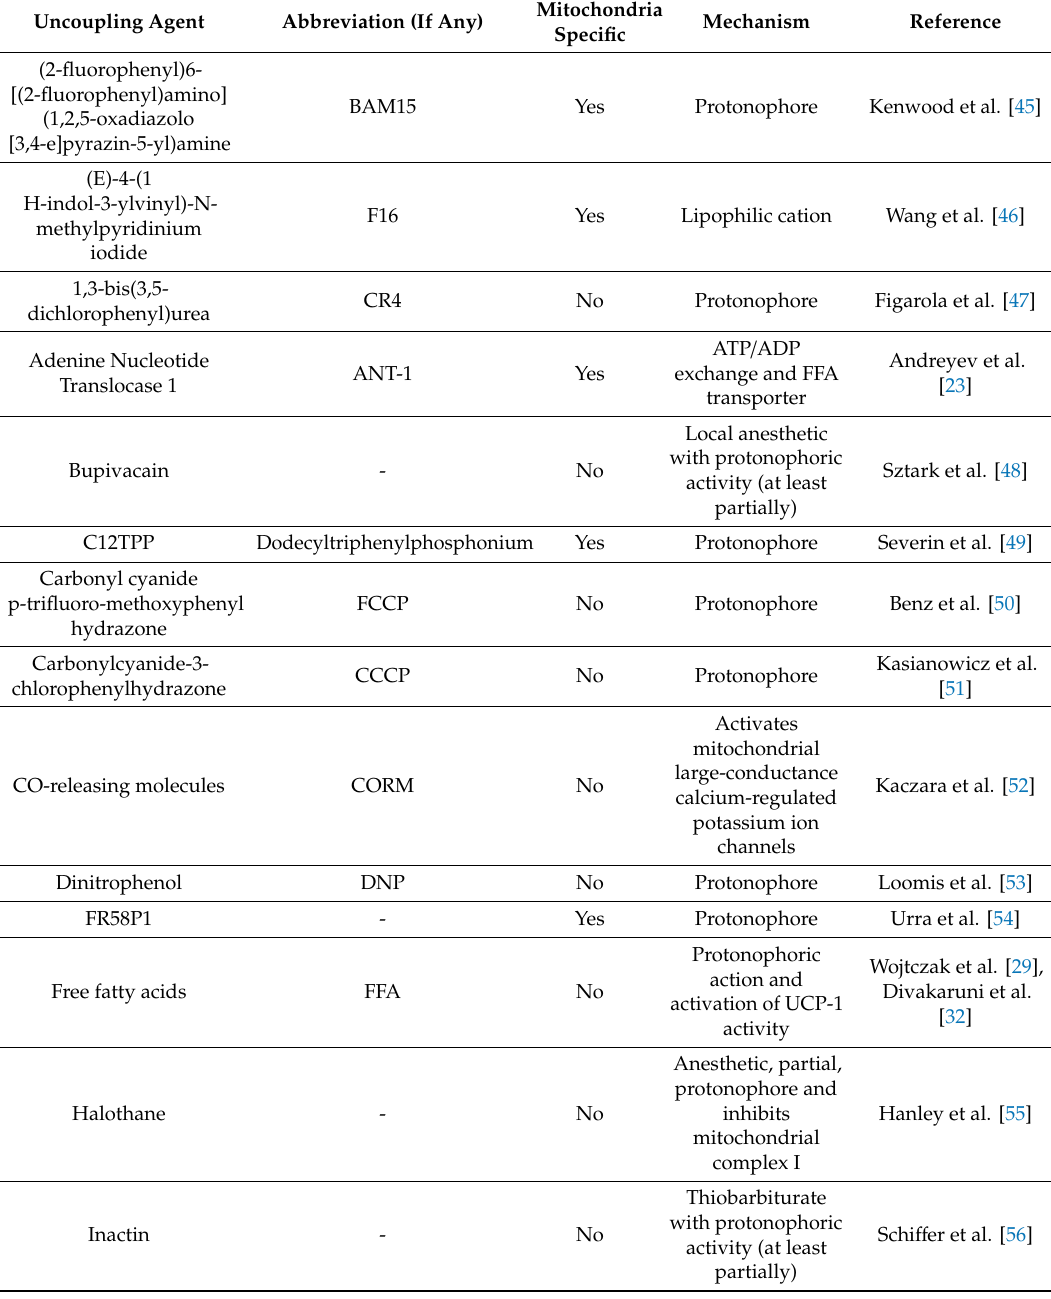
Table 1. List of mitochondrial